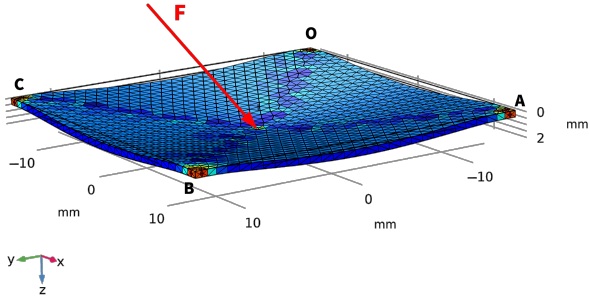
Figure 3. Schematic diagram of the deformation